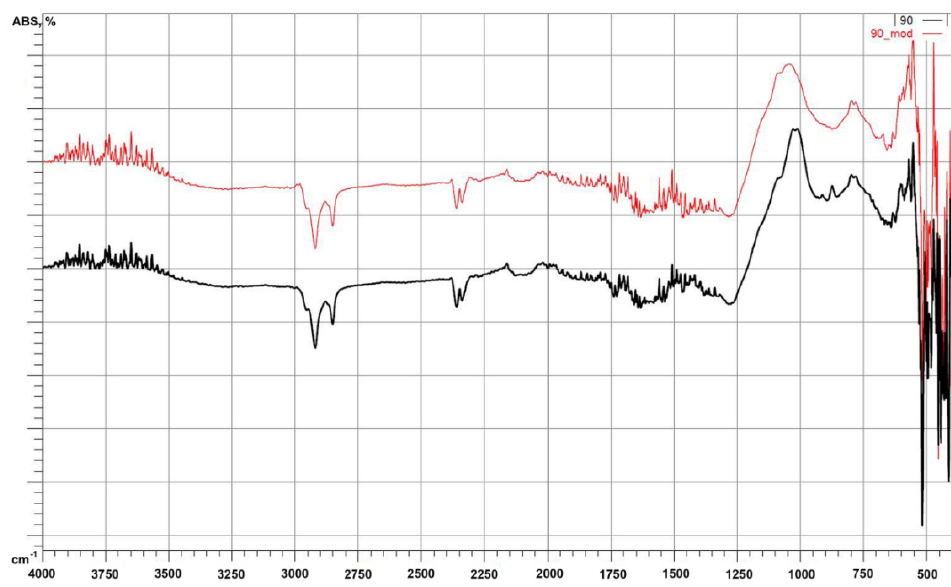
Figure 12. Comparison of FTIR spectra for 90-F_90 and 90_mod-M_90.